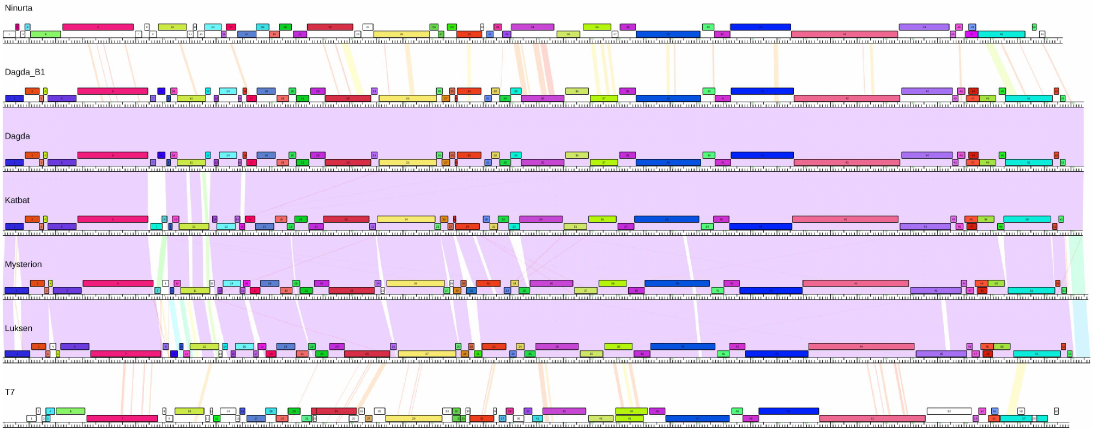
Figure 2. Phamerator map [25]: Pairwise alignment of Mysterion, Dagda, Dagda_B1 Katbat, Luksen and Ninurta with the genome of Enterobacteria phage T7 (NC_001604) included as a reference. Each genome is represented by a vertical line with intersecting colored lines representing nucleotide similarity, red being more dissimilar and violet being more similar. Colored boxes represent genes.